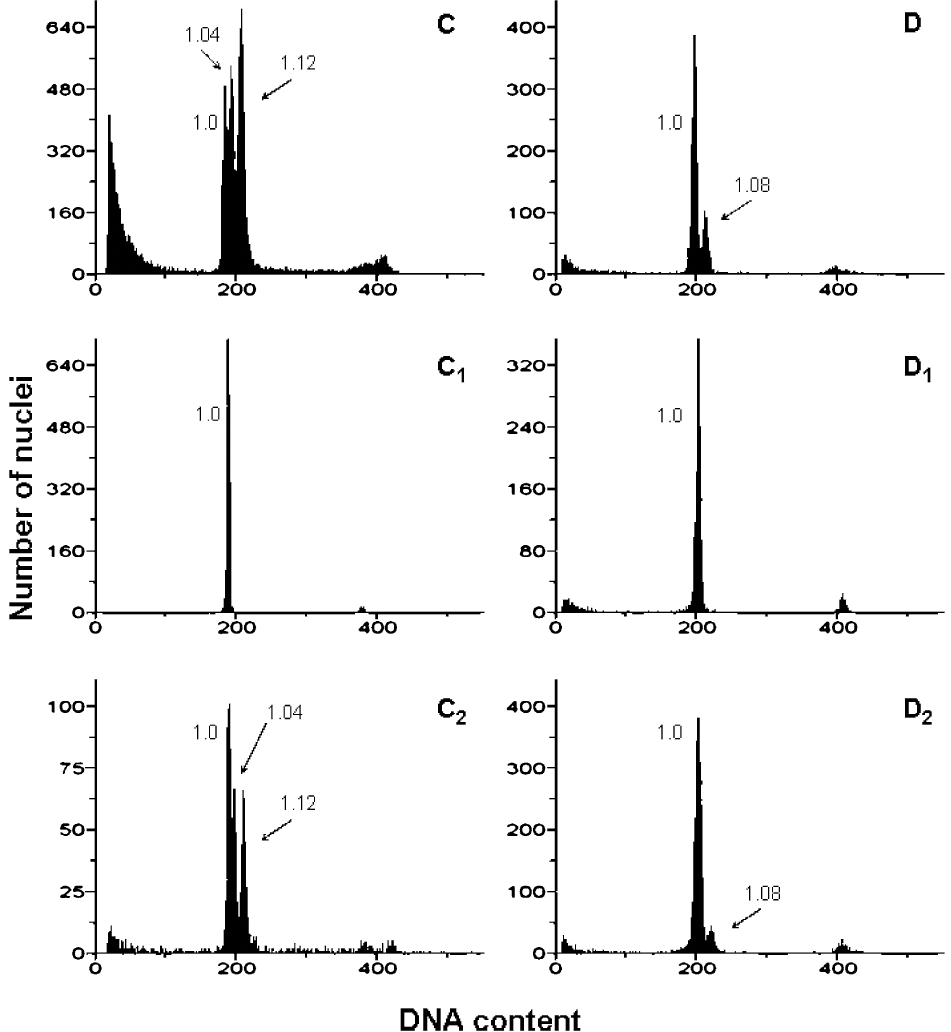
Fig. 1b. (C, C 1 and C 2 ) Two DNA near-diploid aneuploid sublines with DIs, respectively, 1.04 and 1.12 were detected within a gingiva OSCC. (D, D 1 and D 2 ) Example of a relatively small DNA near-diploid aneuploid subline with DI = 1 . 08 within a non-dysplastic soft palate